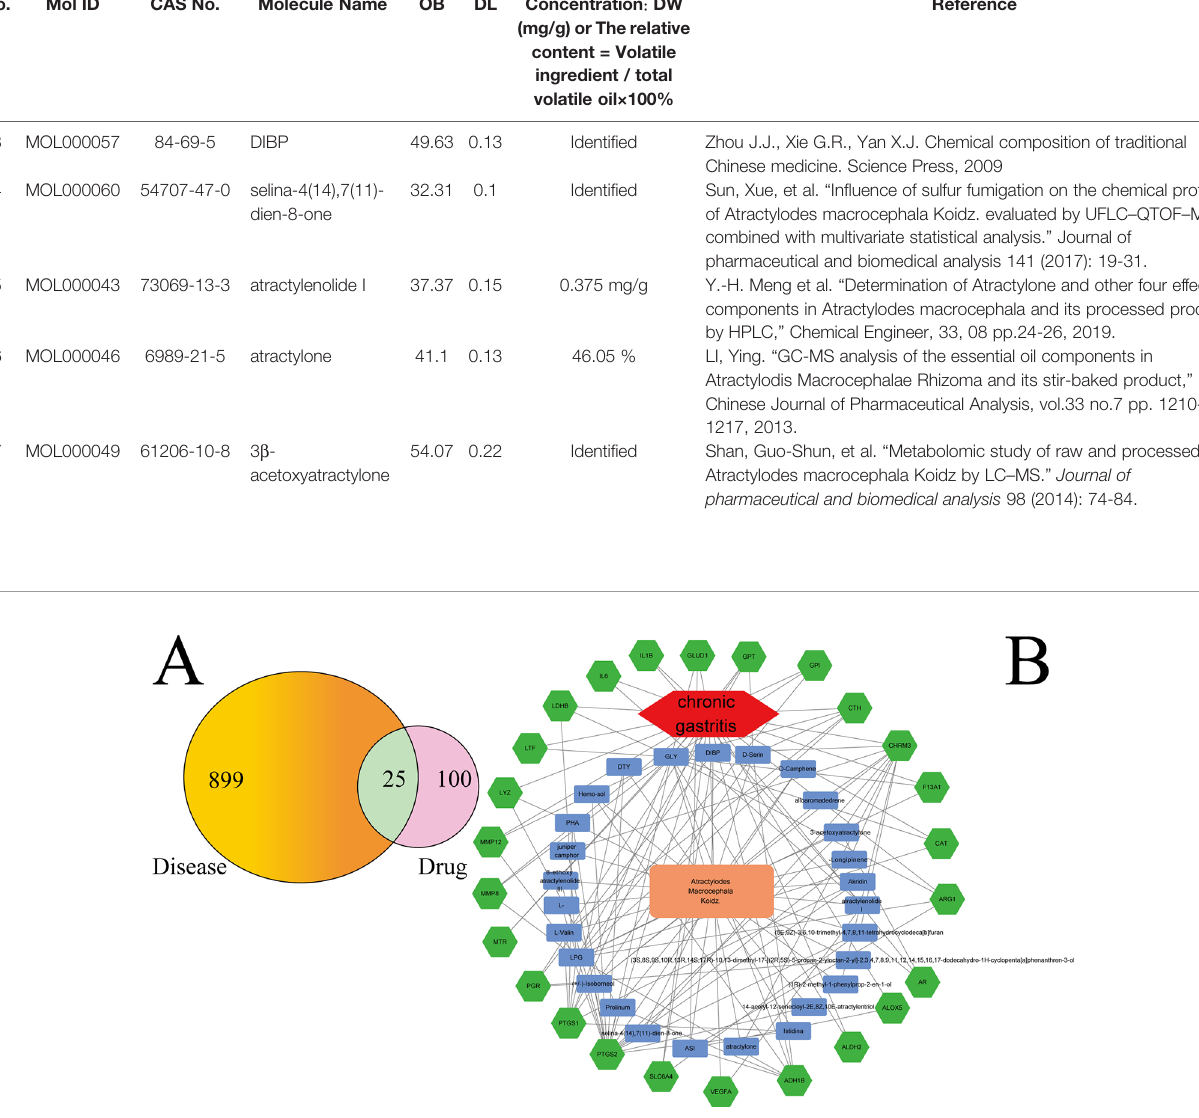
FIGURE 2 | (A) Twenty- fi ve overlapping gene symbols between the disease and drug. (B) D-I-G-D network. The orange node represents AMK and the red node represents CG. The 27 blue nodes represent the active ingredients in AMK; The 25 green nodes represent the overlapping gene symbols between the disease and drug. The edges denote that nodes can interact with each